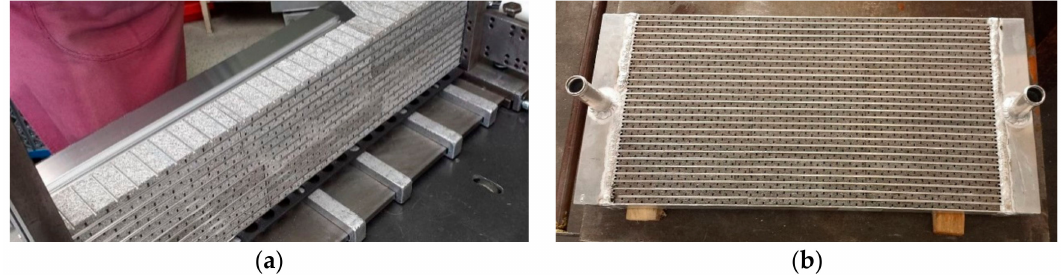
Figure 19. ( a ) Assembly of a heat exchanger with AlSi1 short-fiber structures by stacking flat tubes and AlSi1 short-fiber structures. ( b ) Finished heat exchanger with AlSi1 short-fiber structure, total fiber structure volume 6.7 L, core dimensions 600 mm × 316 mm × 45